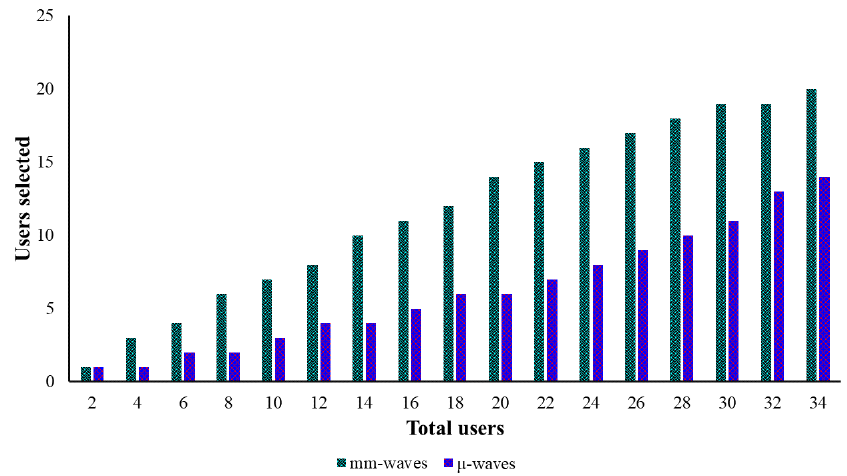
Figure 8. Selected users on mm-waves and µ waves.